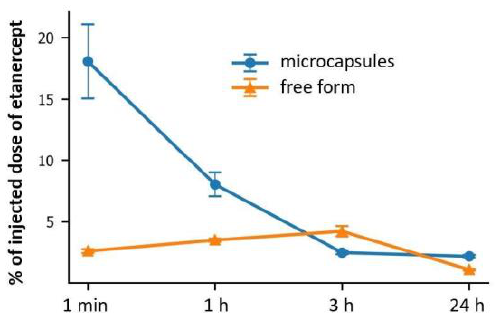
Figure 5. Dynamics of changes in the content of Cy7-labeled etanercept in encapsulated and free forms in the kidneys with their renal artery injection. The evaluation was carried out by fluorescence measurements of organ trypsinization products (excitation at 745 nm, detection at 785 nm).